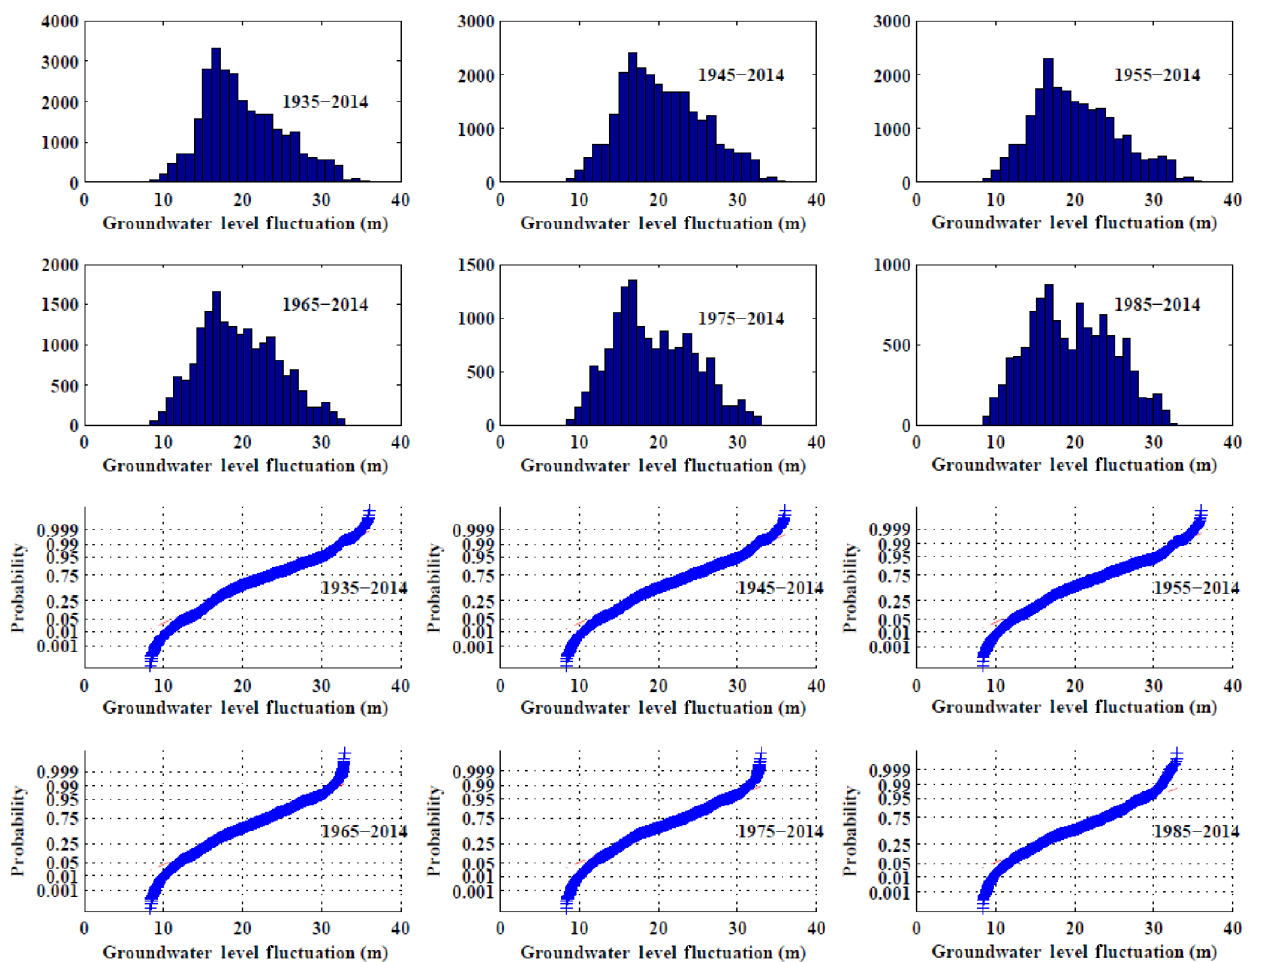
Figure 11. Histograms and normal probability plots for various time intervals of groundwater levels of Well